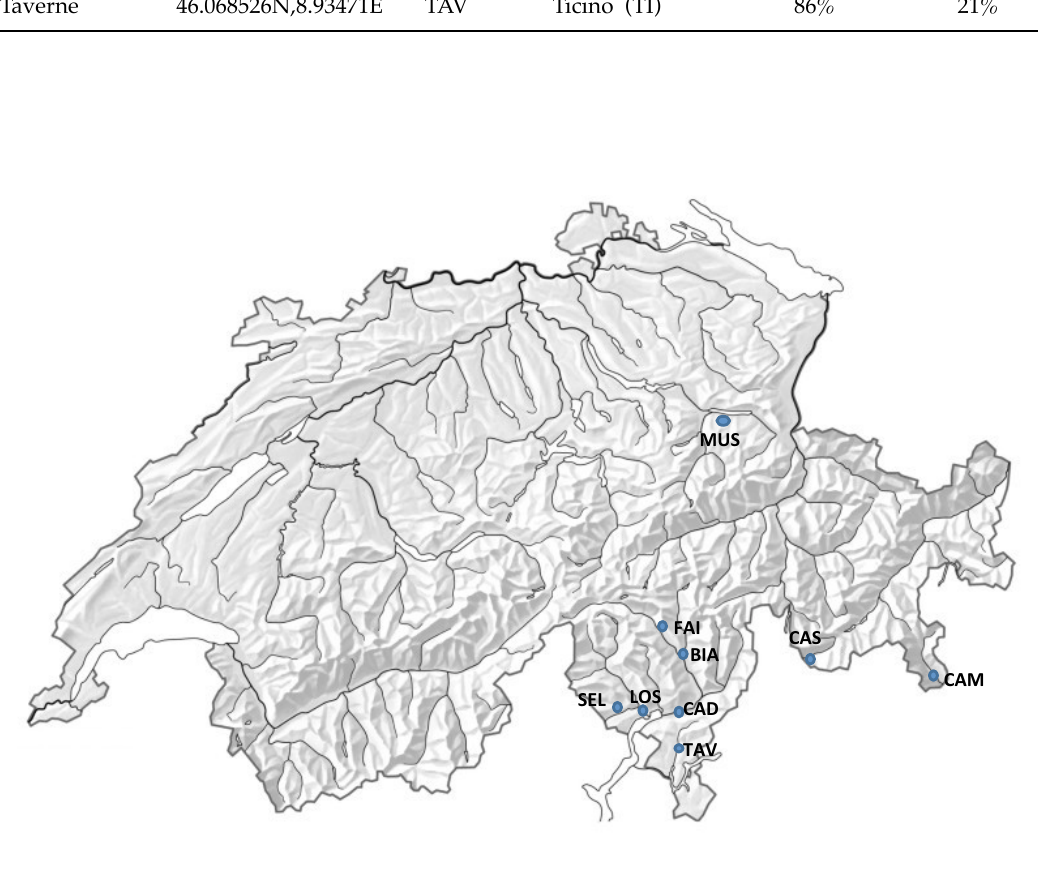
Figure 1. Location of sampling sites in Switzerland (background map: ©Swisstopo, Bern 2005) from which sweet chestnuts were sampled for this